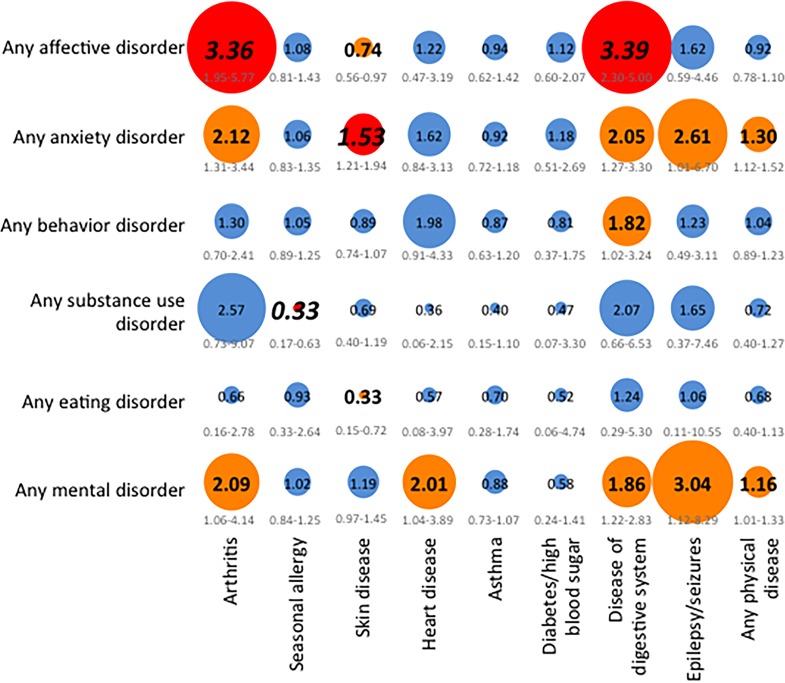
Adjusted discrete-time proportional hazard models estimating the temporal associations of mental disorders predicting subsequent physical diseases.Note: We based our analyses on completer sample sizes* of the total study sample (N = 6483), and adjusted for sociodemographic variables shown in Table 1. The strength of the associations (hazard ratios (HR) is illustrated by the circle diameter, given in the circles, and 95% confidence intervals, given below the circles). Blue color of the circle (and HRs provided in small standard type font) represent p≥0.05 in the total study sample; orange color of the circle and HRs provided in medium-sized bold type font represent p<0.05 in the total study sample and in less than two independent subsamples; red color of the circle and HRs provided in large bold and italic type font represent p<0.05 in the total study sample and in at least two independent subsamples. * Due to missing information on physical diseases from adolescent self-report, sizes of the completer samples are as follows: arthritis: n = 6473, seasonal allergy: n = 6475, skin disease: n = 6479, heart disease: n = 6481, asthma: n = 6477, diabetes/high blood sugar: n = 6481, disease of the digestive system: n = 6481, epilepsy or seizures: n = 6481, any physical disease: n = 6469.